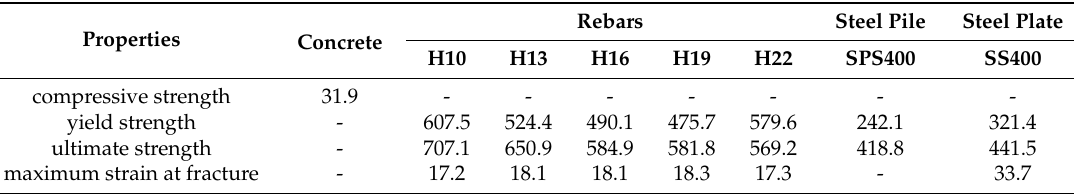
Table 2. Material properties of test specimens. (unit: MPa (strength), % (strain)).